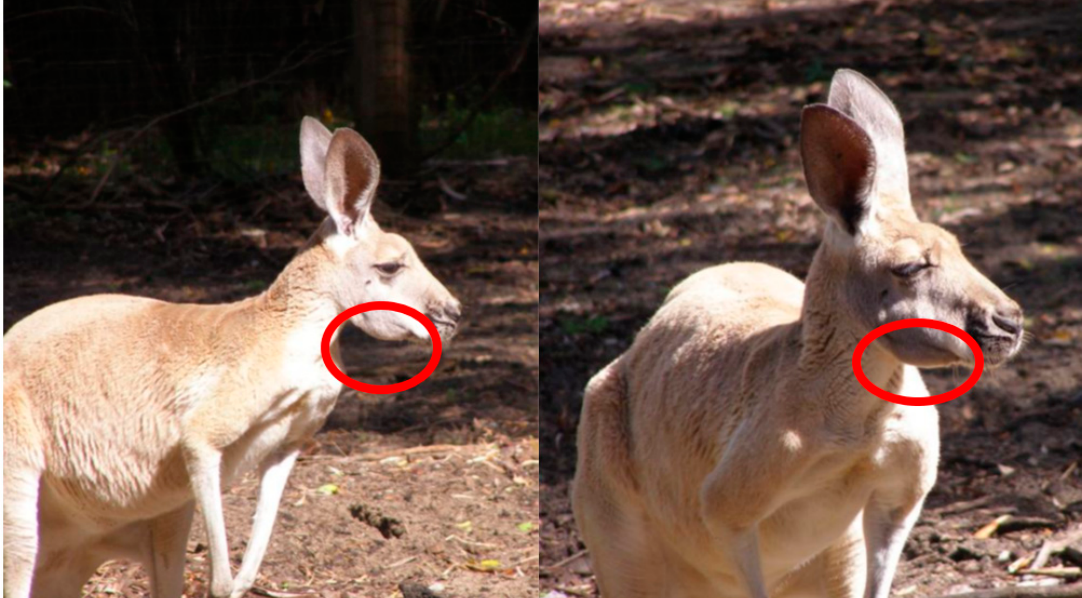
Figure 1. Swelling of the mandibular region (encircled) associated with clinical signs of Macropod Progressive Periodontal Disease (MPPD) in a red kangaroo ( Macropus rufus ). (Images courtesy of Perth Zoo).